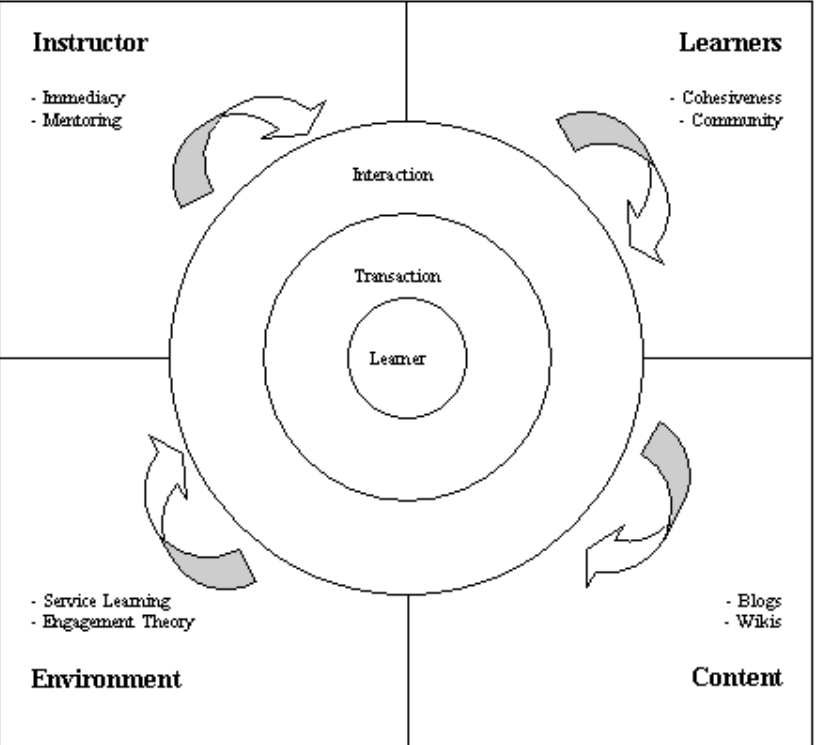
Figure 1. Proposed Model of